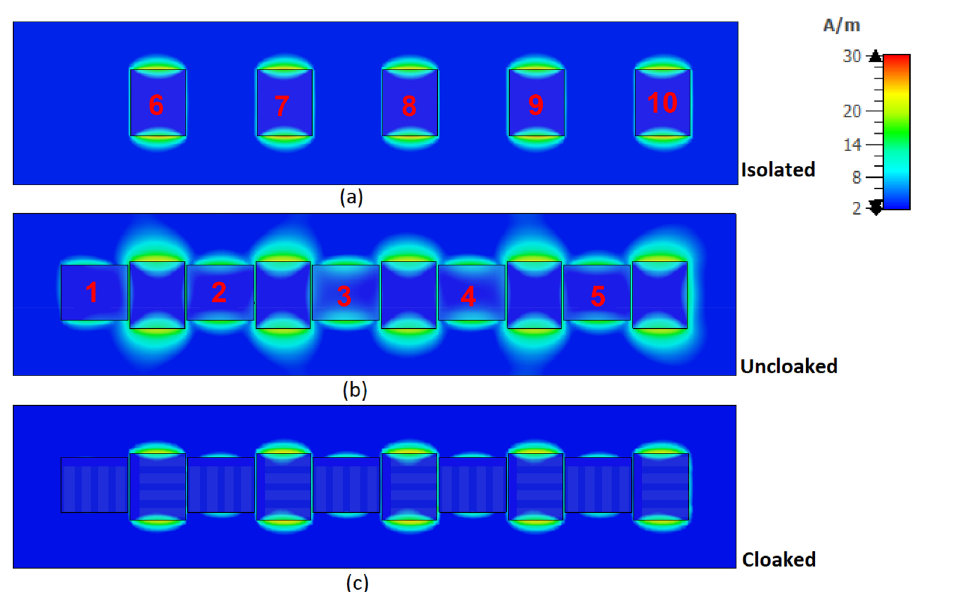
Figure 11. Measured reflection coefficients of the elements of the ( a ) cloaked array I, and ( b ) cloaked array II.